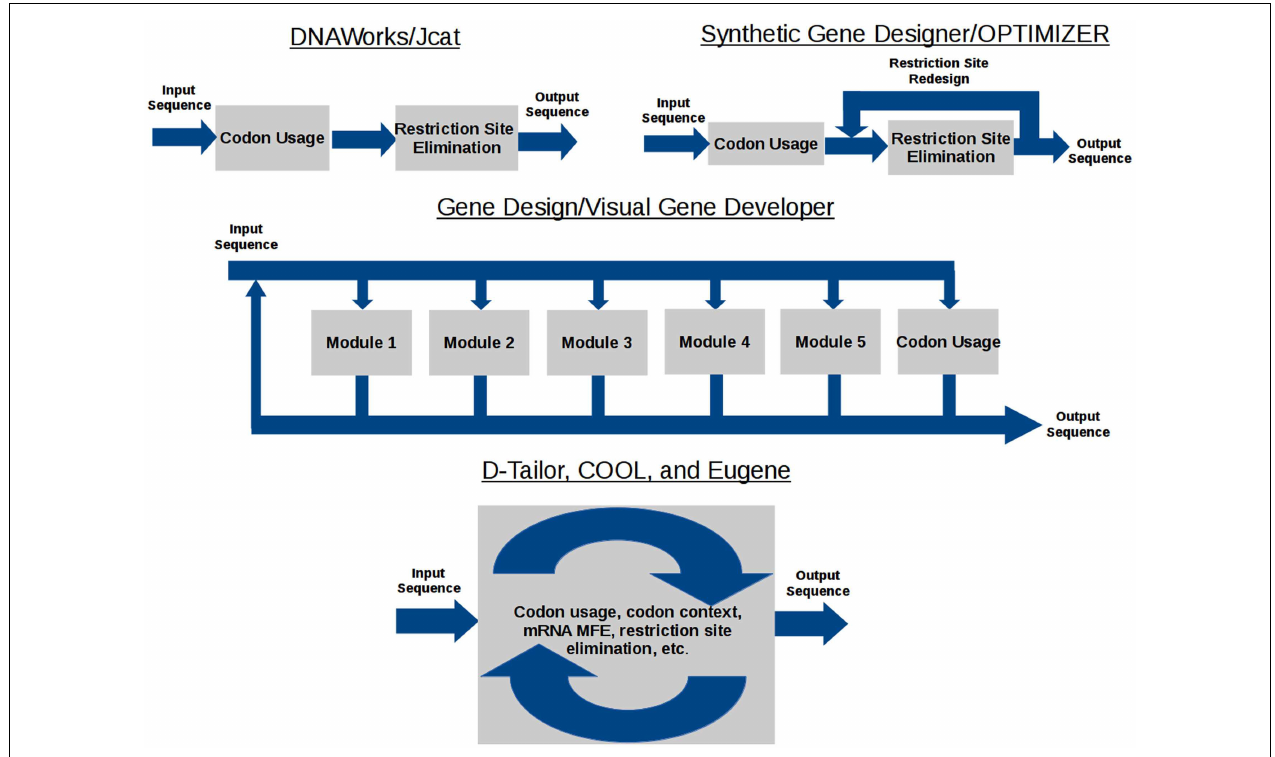
FIGURE 1 | Gene design software data flow